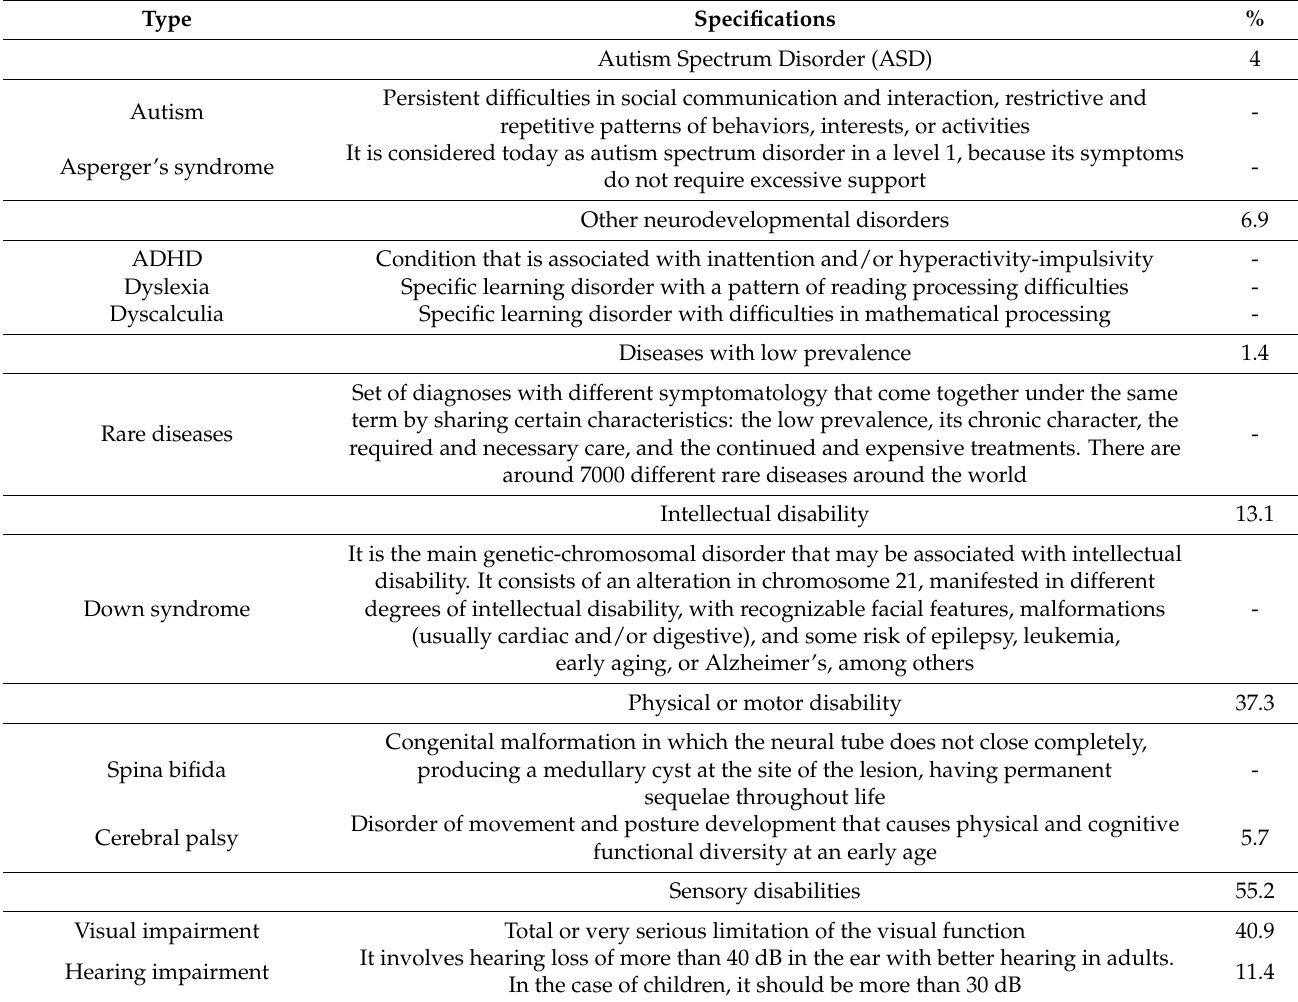
Table 1. Types of functional diversity analyzed in this study 1